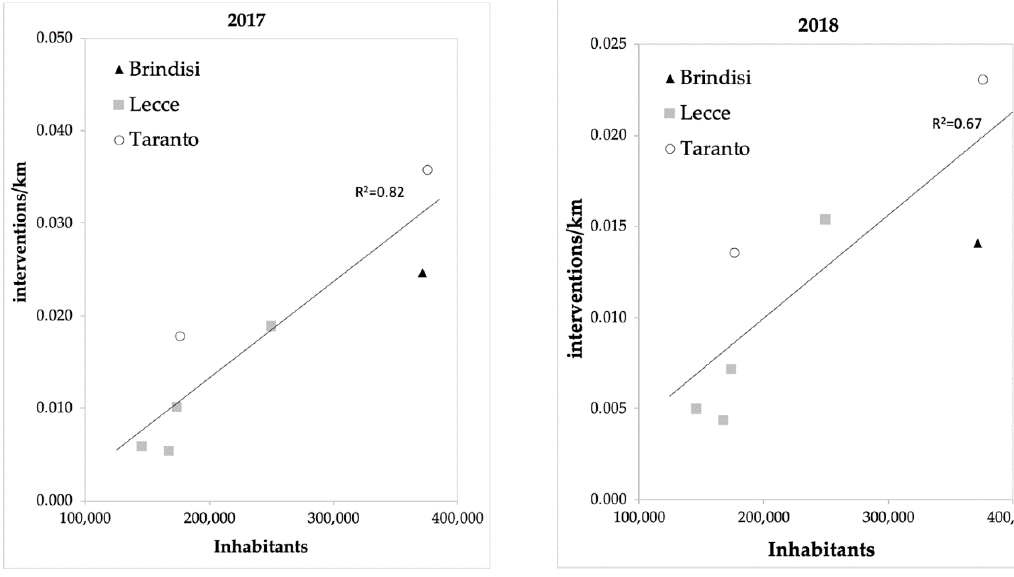
Figure 4. Interventions per kilometer of wastewater pipelines vs. inhabitants [15].